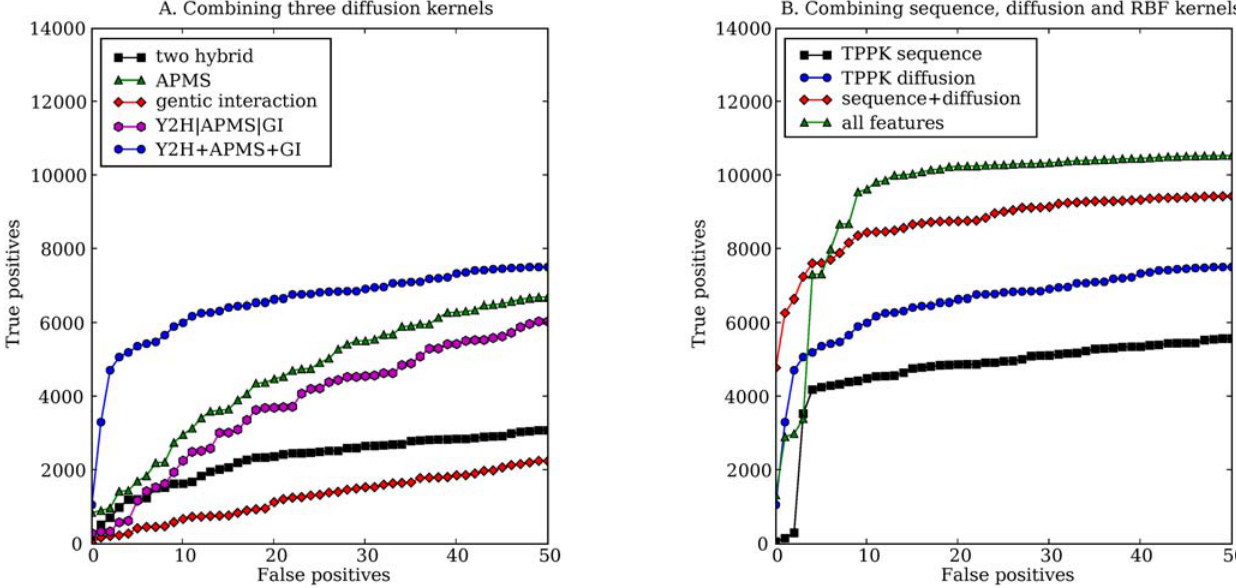
Figure 2. Combining different kernels. (A) Two-hybrid, APMS, and genetic interaction represent the performance of an SVM trained using the TPPK of the diffusion kernel on a single network. Y2H|APMS|GI uses the diffusion kernel derived from a single network containing two-hybrid, APMS, and genetic interaction edges. Y2H + APMS + GI represents the summation of three diffusion kernels based on the three networks. (B) The TPPK sequence kernel is the TPPK of the summation of Pfam, motif, and spectrum kernels. The TPPK diffusion kernel is the same as Y2H + APMS + GI in (A). The sequence + diffusion kernel is the TPPK of the summation of the three sequence kernels and the three diffusion kernels. The all features kernel is the summation of the sequence + diffusion kernel with the RBF kernel.